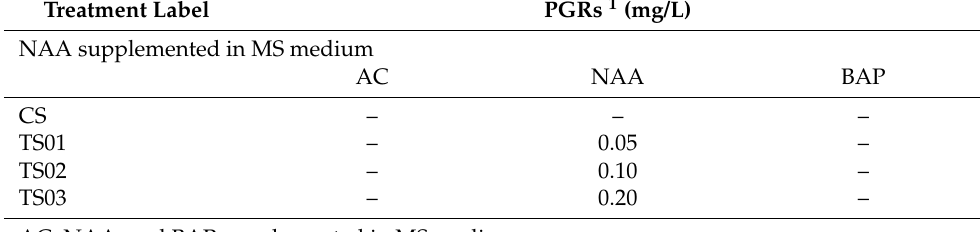
Table 1. Experimental treatments of Murashige and Skoog (MS) medium supplemented with different combinations and concentrations of activated charcoal (AC) and plant growth regulators (PGRs). Treatment